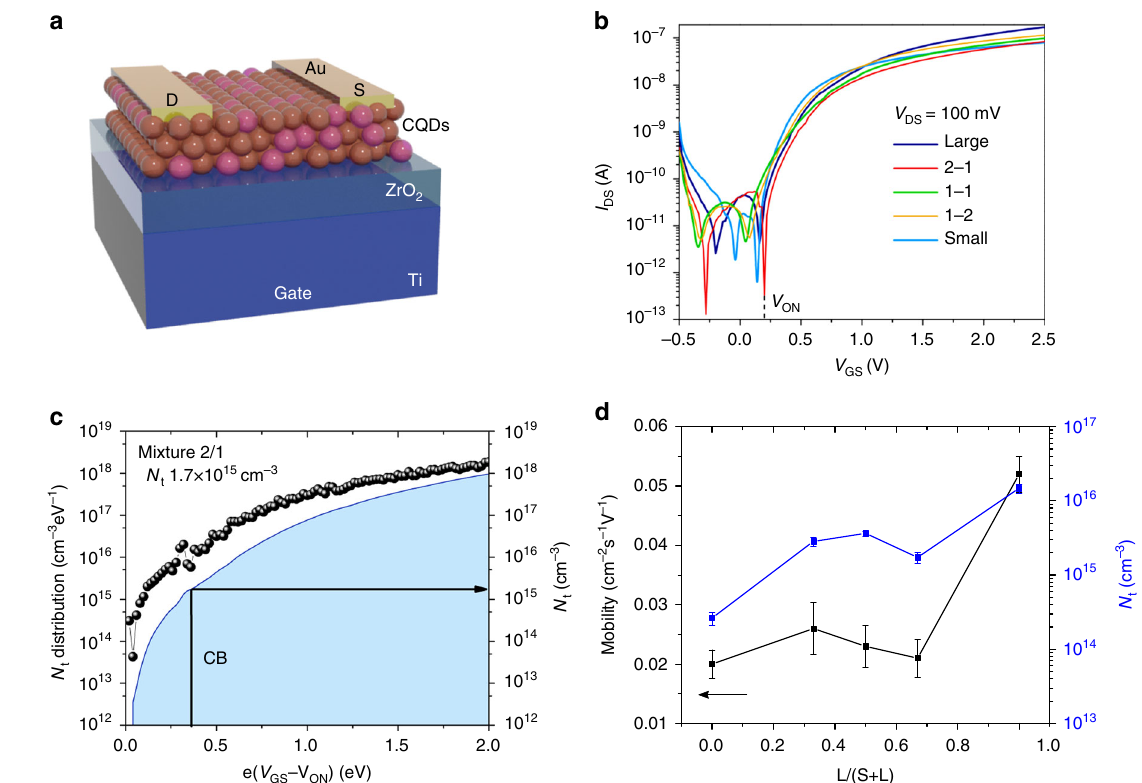
Fig. 2 Transport properties of CQD multi-bandgap ensembles a bottom-gate top-contact fi eld-effect transistor structure; transfer characteristics of pure CQD and multi-bandgap CQD ensembles with different weight ratio of large bandgap (L) to small bandgap (S) CQDs showing onset voltage ( V ON ) b , transfer characteristics of pure and mixed CQDs with different weight ratios of large bandgap (L) to small bandgap (S); c tail state density ( N T ) of the optimal CQD mixture (weight ratio of 2 to 1) as a function of gate bias as calculated with Eq. (3); d mobility and trap density as a function of the inclusion